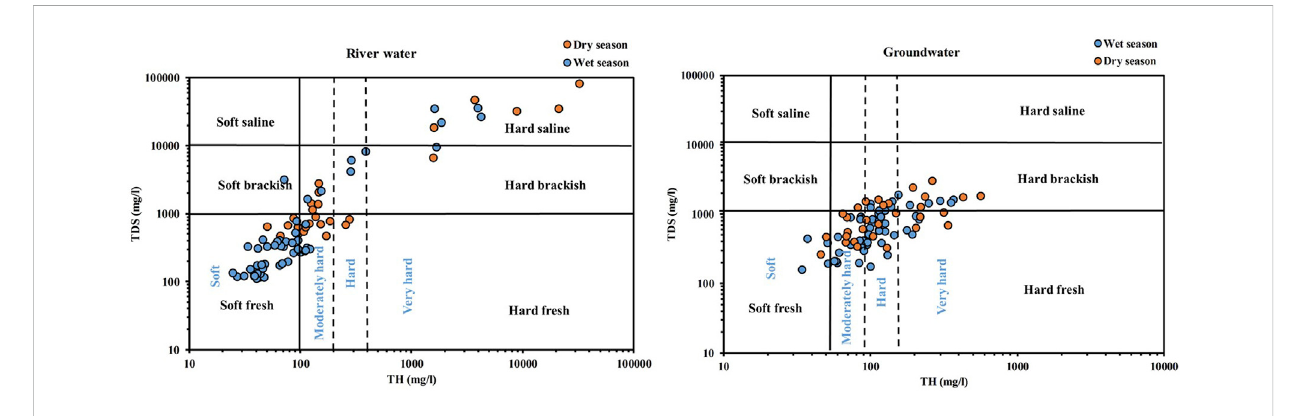
FIGURE 2 Relationship between TDS and